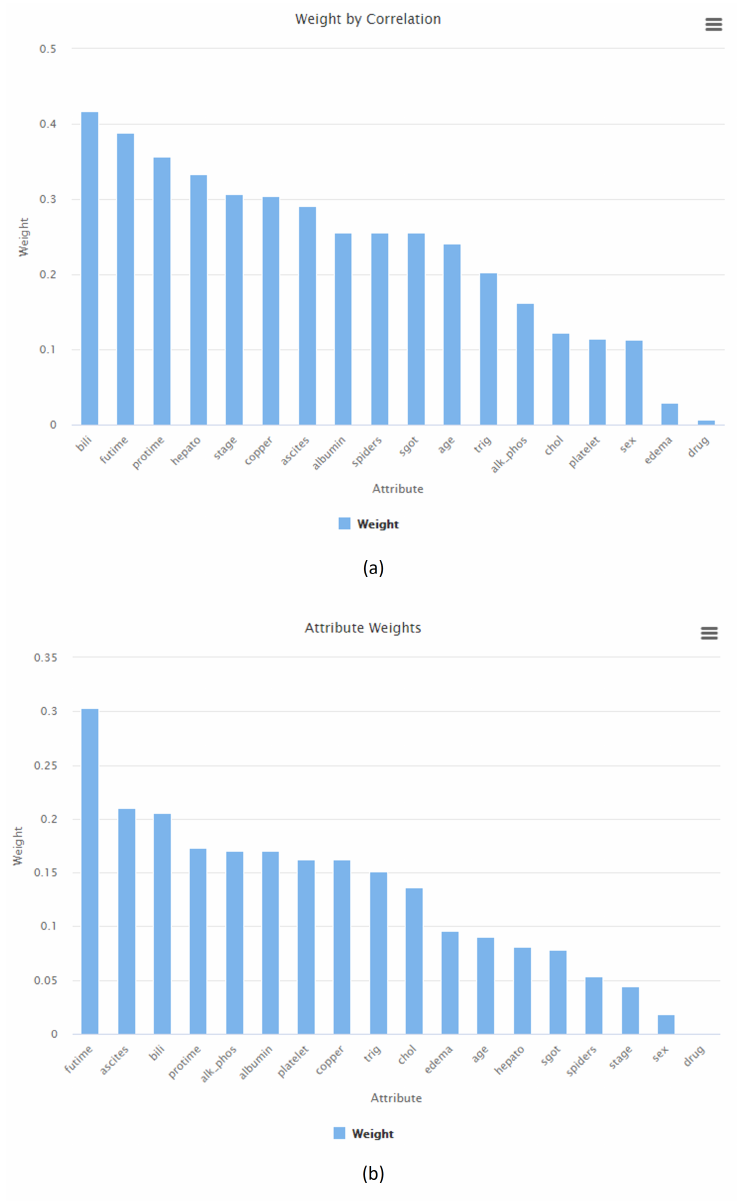
Figure 6. ( a ) Weight by Information Gain Ratio. ( b ) Feature weight